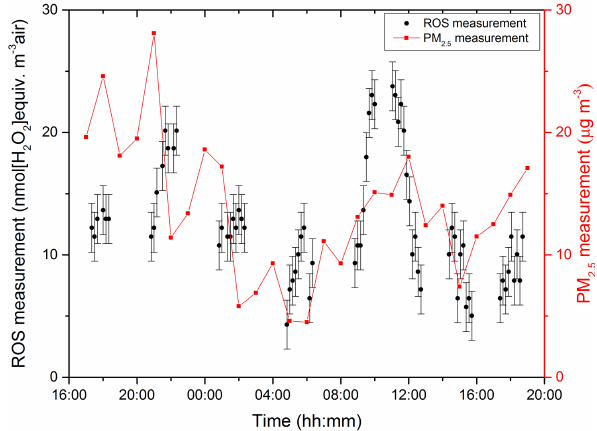
Figure 8. A ∼ 24h time series of ambient ROS measurement from an urban roadside site in central London, UK (Marylebone Road). Black circles represent 10min averages of OPROSI data (nmol [H 2 O 2 ] equivalents per m 3 air); error bars span 1 × LOD. Red squares show hourly averages of PM 2 . 5 (µgm − 3 )